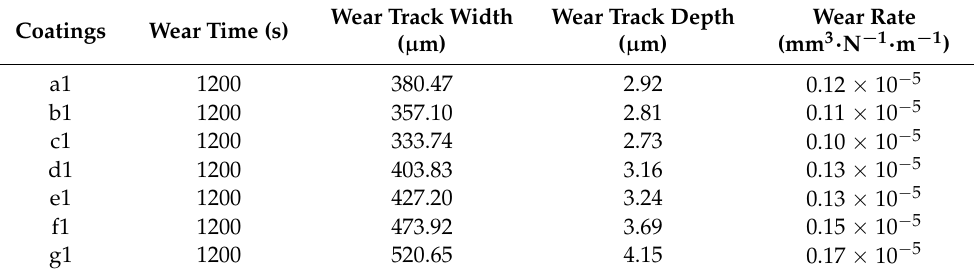
Table 5. Wear rates of the MAO self-lubricating composite coatings formed on aluminum alloys at different anode